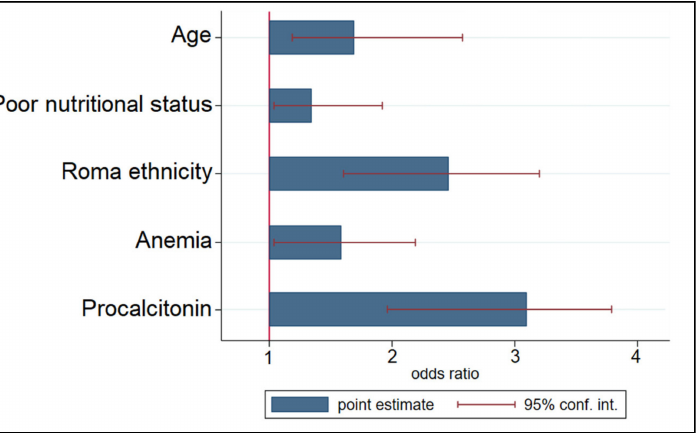
Figure 3. Multivariate risk factor analysis for developing pneumonia in children and adolescent patients with